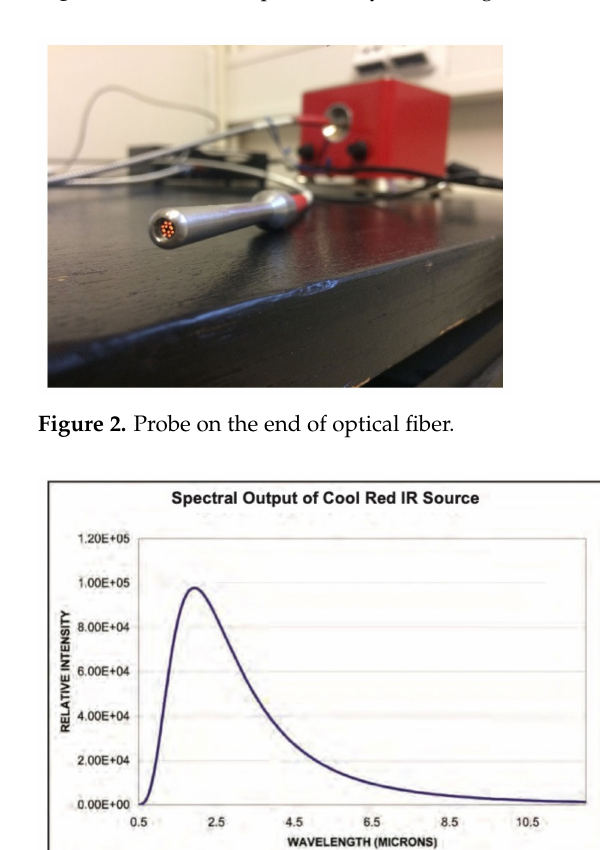
Figure 1. Reflectance spectrometry measuring device NIRQuest512-2.5.